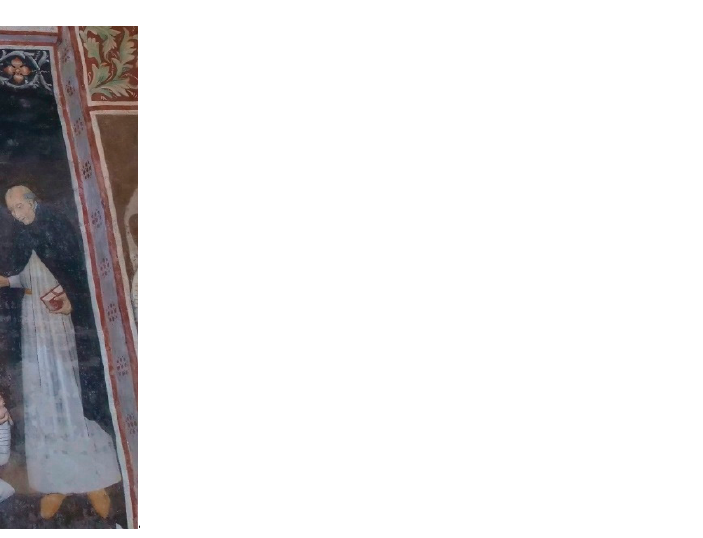
Figure 4. Vincent Ferrer saving a child. Santa Maria Assunta Parish Church (Macello, Piedmont). Aymo Duce and collaborators, circa 1429 (photograph courtesy of Leonardo Guazzo).